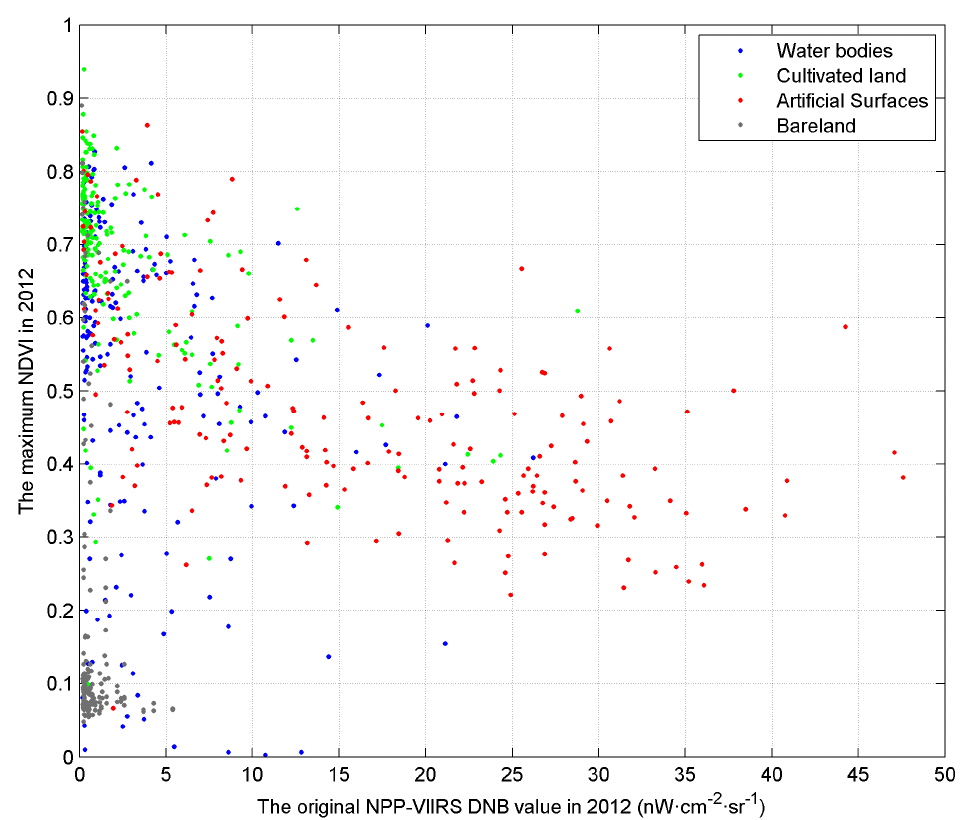
Figure 12. The distribution frequency of the NPP-VIIRS DNB value and the MODIS NDVI value of four easily-confused land cover types (200 random samples): water bodies, cultivated land, artificial surfaces and bare land. The x -axis is the original NPP-VIIRS DNB value in 2012, and the y -axis is the maximum NDVI in 2012. Points with DNB values greater than 50 nW · cm − 2 · sr − 1 are not